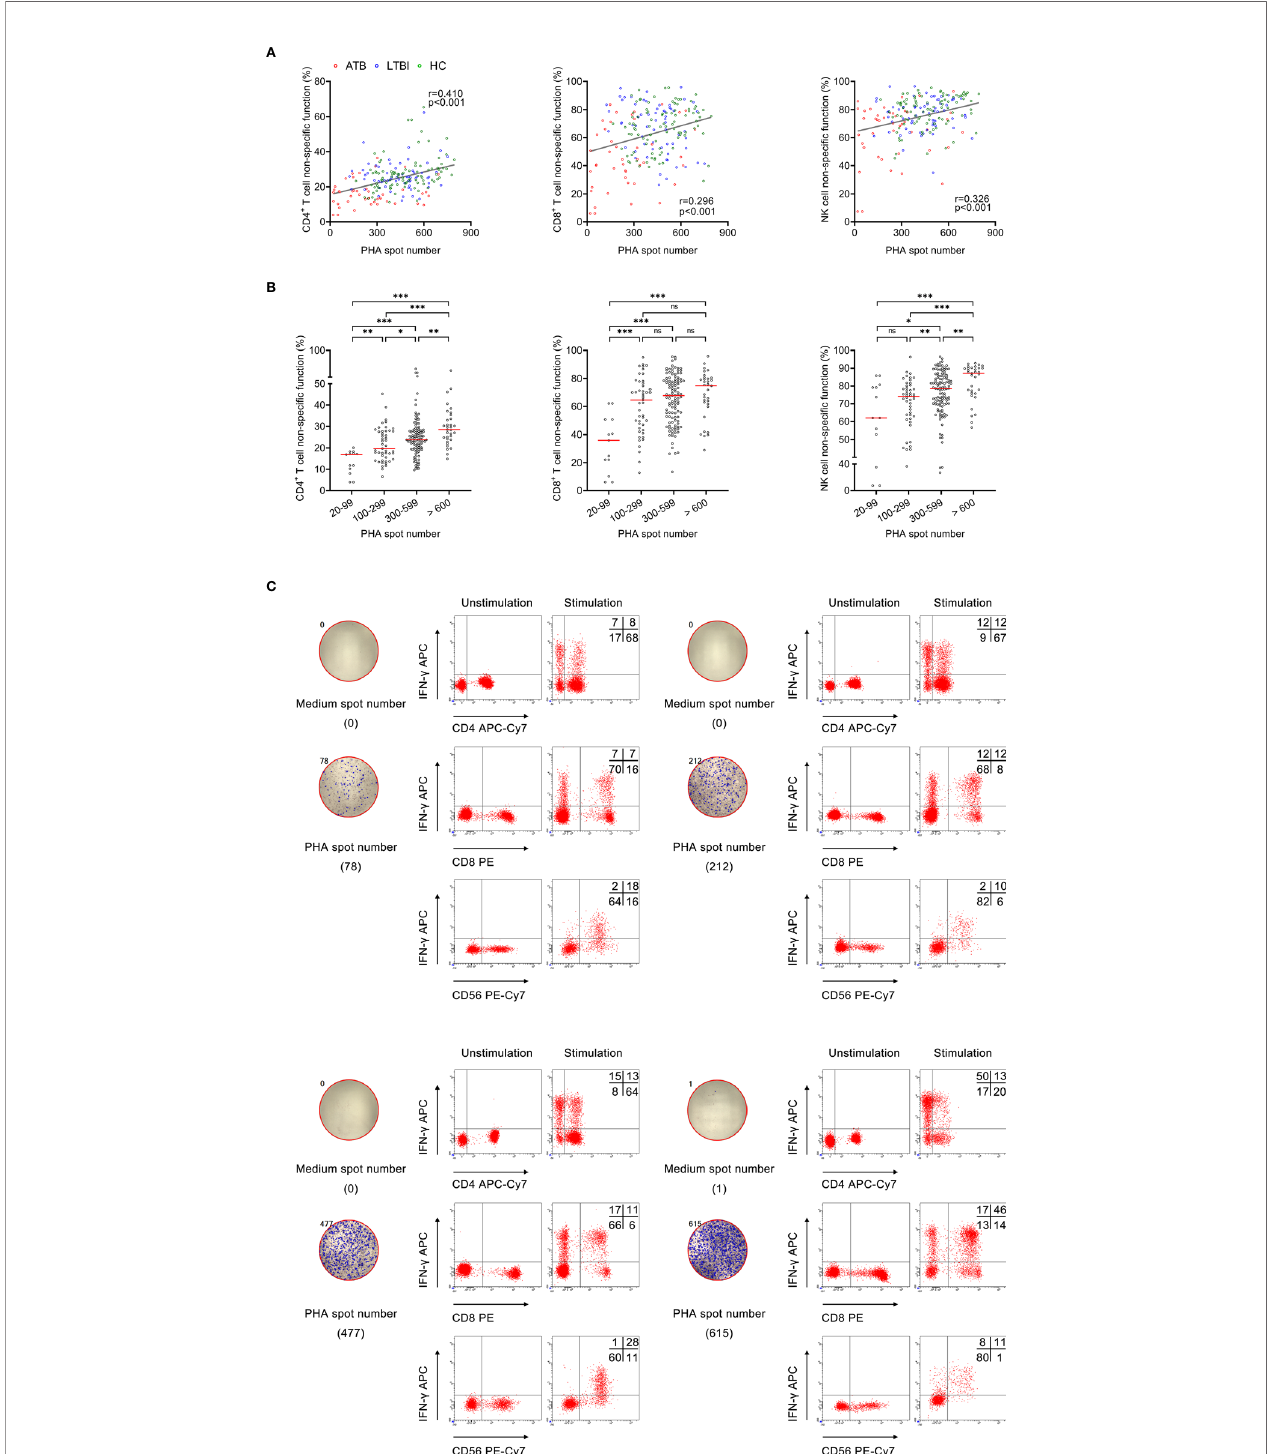
FIGURE 1 | The relationship between PHA spot number and lymphocyte non-speci fi c function. (A) Correlation between PHA spot number and non-speci fi c function of CD4 + T cells, CD8 + T cells, and NK cells in 208 participants. Each symbol represents an individual donor. (B) Scatter plots showing the results of CD4 + T cell non-speci fi c function, CD8 + T cell non-speci fi c function, and NK cell non-speci fi c function under different PHA spot number. Horizontal lines indicate the median. * P < 0.05; ** P < 0.01; *** P < 0.001; ns, no signi fi cance (Mann-Whitney U test). (C) Flow plots showing the representative results of CD4 + T cell non-speci fi c function, CD8 + T cell non-speci fi c function, and NK cell non-speci fi c function under different PHA spot number. PHA,